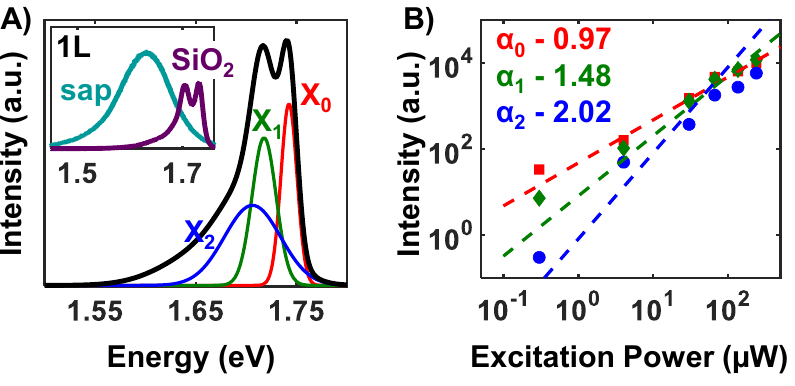
for different excitation power (P ) of the peaks marked in Ex . The slope of Figure 3A and their fi t to the power law I ∝ P a Ex the power law fi t corresponds to α and has been indicated at ∼ 1.74 eV showed in the fi gure. The peak marked as X 0 almost linear dependence on P with α ∼ 0.97 and hence Ex can be attributed to neutral exciton [14]. The PL intensities of the other two peaks were observed to increase more steeply with P ,thereby indicating theirorigin to be higher Ex order excitons. The peak marked as X at ∼ 1.72 eV showed 1 super-linear behaviour with α ∼ 1.48 which is a character-